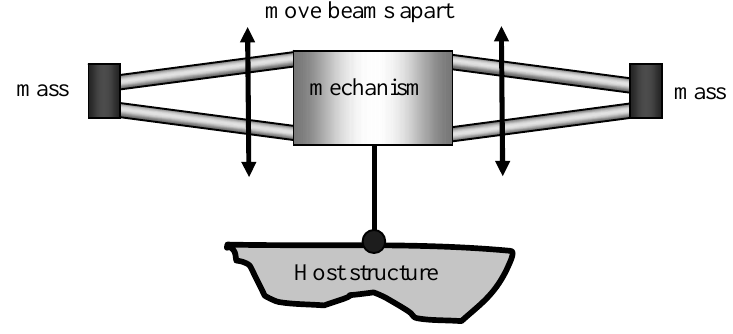
Fig. 1. A beam-like vibration absorber where the stiffness is adjusted by moving the beams apart.